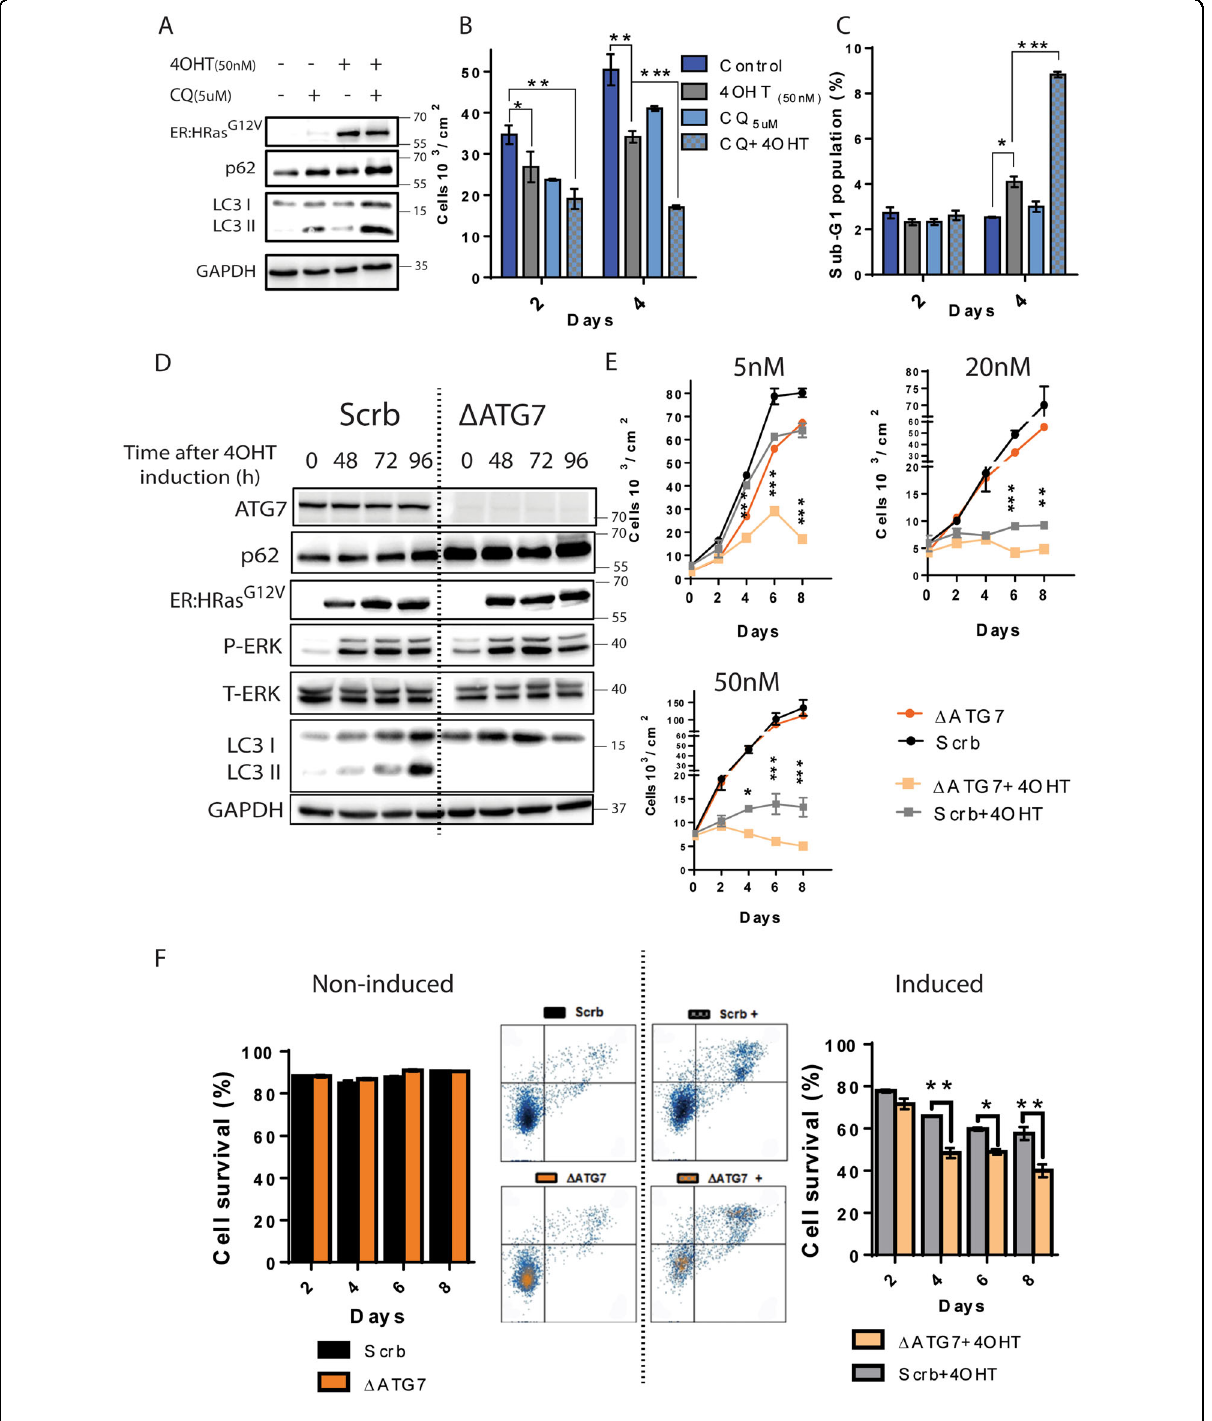
Fig. 6 (See legend on next